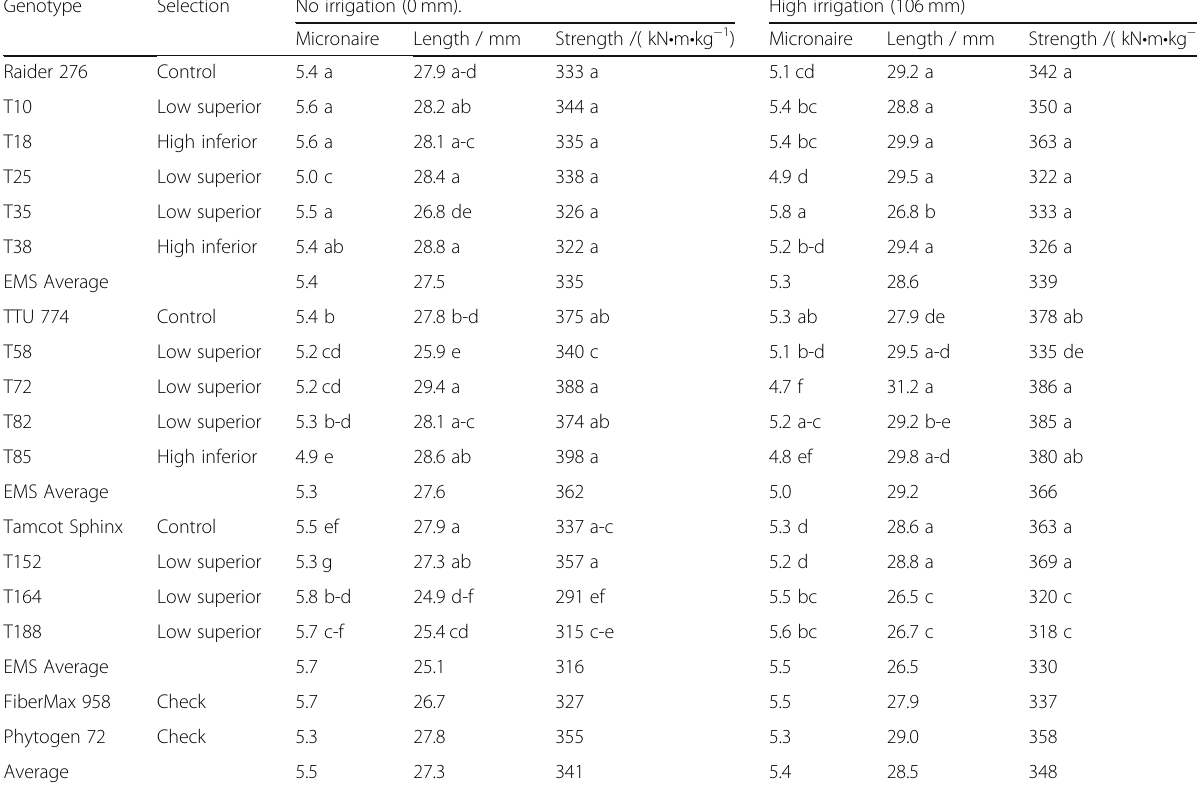
Table 5 Fiber quality of tetraploid selections at Lubbock, TX (Location 1) in 2016 Genotype